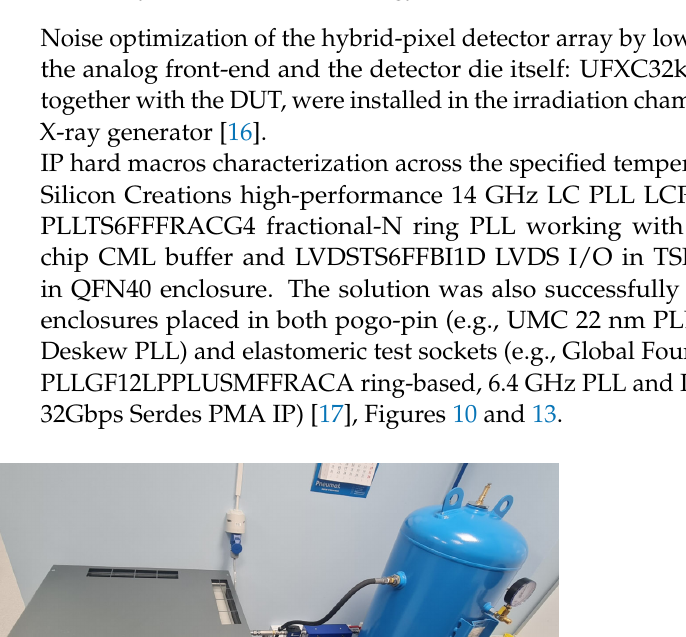
Figure 13. Dry air installation in the Silicon Creations Laboratory supplying thermal chambers and Thermal Elephant units with the dry air.